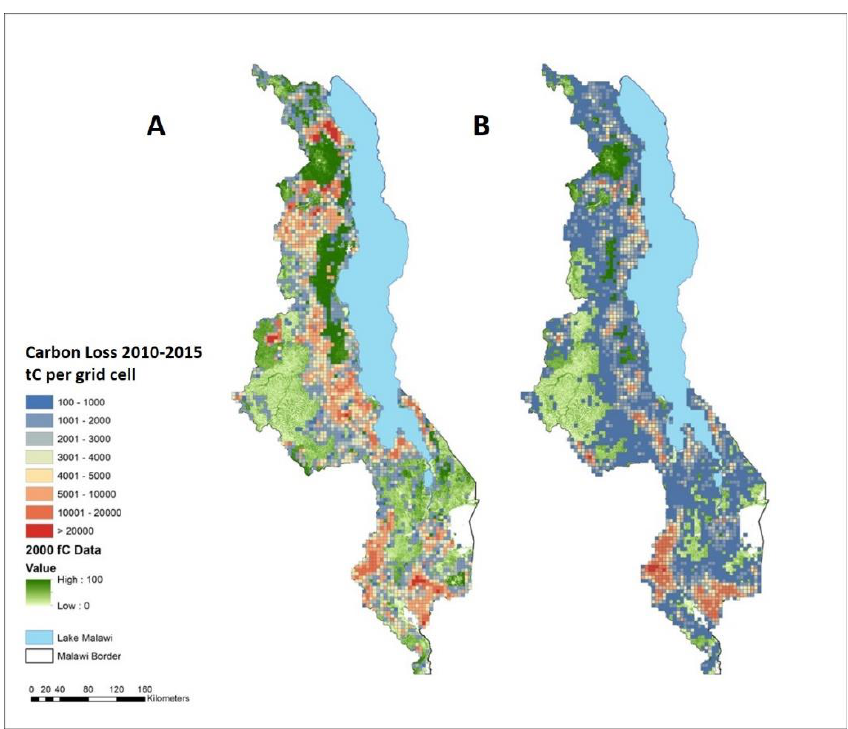
Figure 11. An estimate of emissions of carbon (10 6 g C per grid cell) from deforestation ( A ) and forest degradation ( B ), 2010–2015. This estimate uses the same method as found in the Government of Malawi’s report on its National Forest Reference Emission Levels [31]. The method follows IPCC guidance in which Emissions = Activity Data × Emission Factors. The Activity Data are produced by this study, and we used Emission Factors from GOM National Forest Reference Emissions Levels report [31].